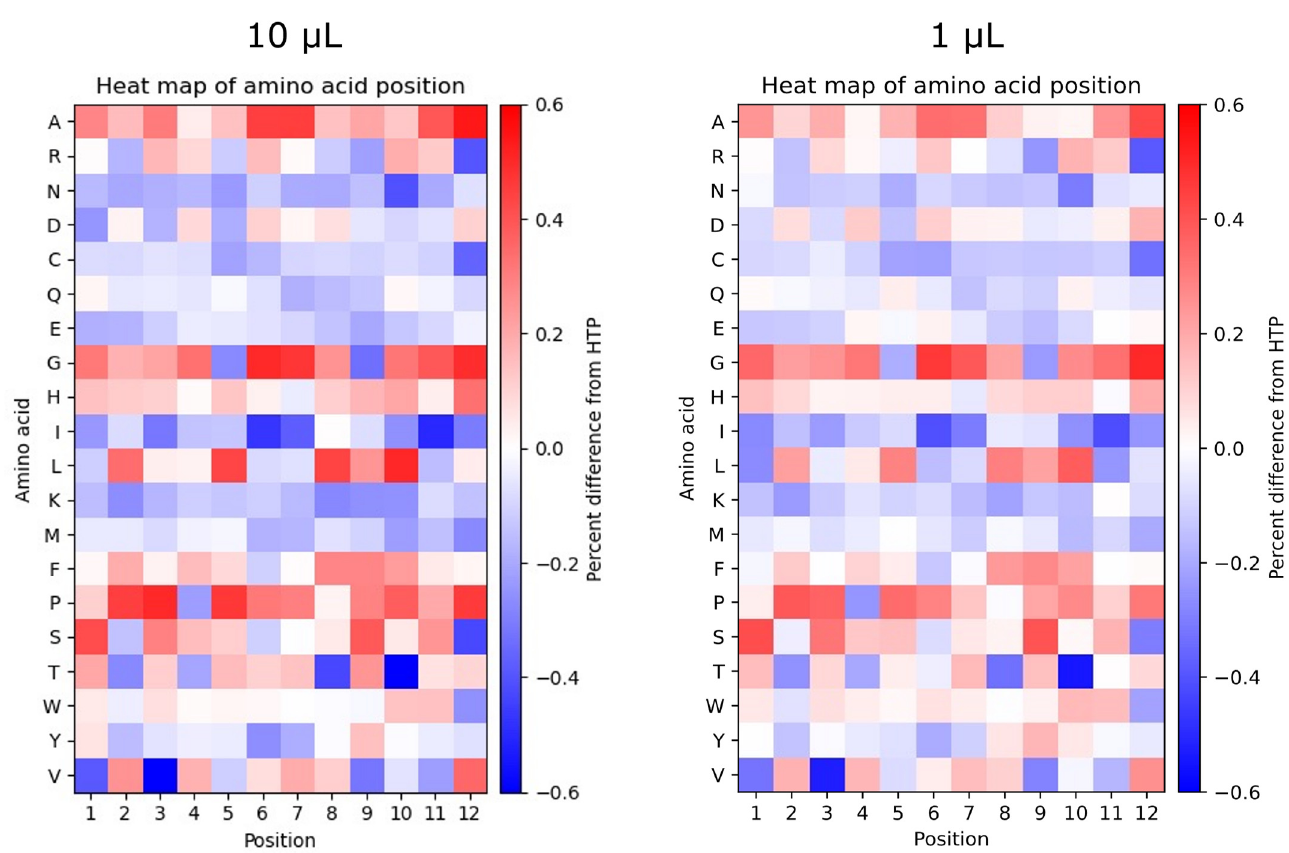
Figure 4. Percentage difference in the positional frequency of amino acids between samples with different sequencing depths. Heatmaps showing the percentage difference in the positional frequency of 10 μ L LTP compared to 10 μ L HTP (left) and 1 μ L LTP compared to 1 μ L HTP (right) for the 12 positions in the displayed peptide and for all amino acids. HTP datasets were used as references, accordingly, the scale indicates percentage difference from HTP. Overrepresentation of amino acids is shown in red, and underrepresentation of amino acids is shown in blue.